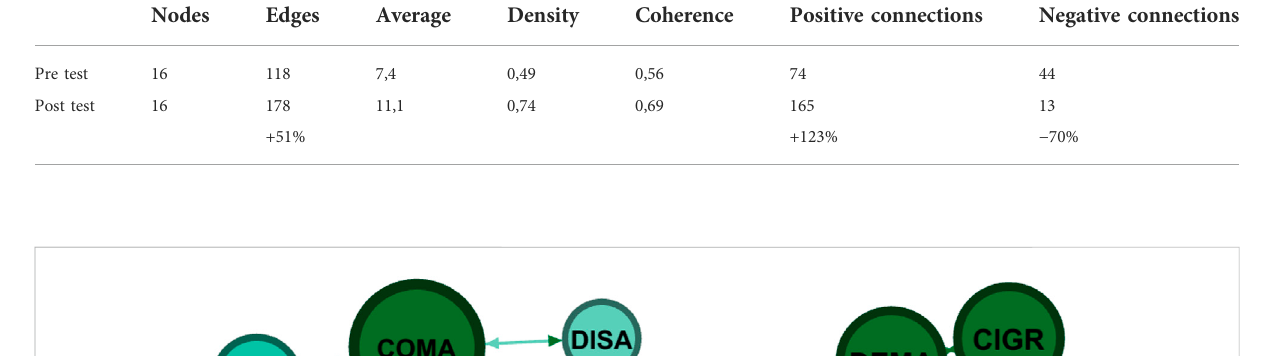
TABLE 2 Sociometric index calculated for the group involved in the trial (group organization). Nodes